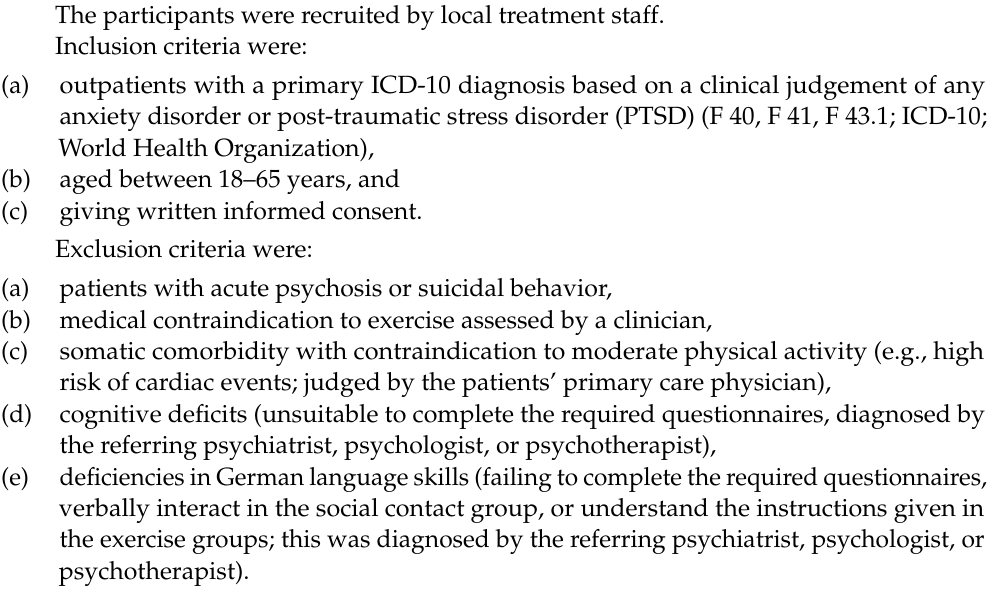
Figure 1. Schedule of the project. Measurement of study outcomes at four timepoints. Notes: BAI: Beck Anxiety Inventory, PCL-5: Post-traumatic Stress Disorder Checklist, BDI-II: Beck Depression Inventory, PSWQ: Penn State Worry Questionnaire, GSE: General Self-Efficacy, QoL: Quality of Life, BP: biological parameters, t1: before the program, t2: at the end of the program, t3: three-month follow-up, t4: six-month follow-up, ✓ : completed questionnaires, 1–8: attended sessions.